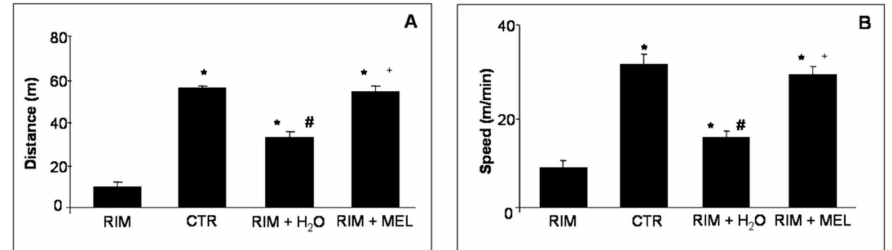
Figure 1. Spontaneous locomotor activity. The graph summarizes the distance travelled ( A ) and the speed ( B ) of spontaneous locomotor activity. * p ≤ 0.05 vs. RIM + H 2 O; # p ≤ 0.05 vs. CTR; + p ≤ 0.05 vs. RIM + H 2 O. CTR: control; H 2 O: tap water; MEL: melatonin; RIM: reserpine-induced myalgia.